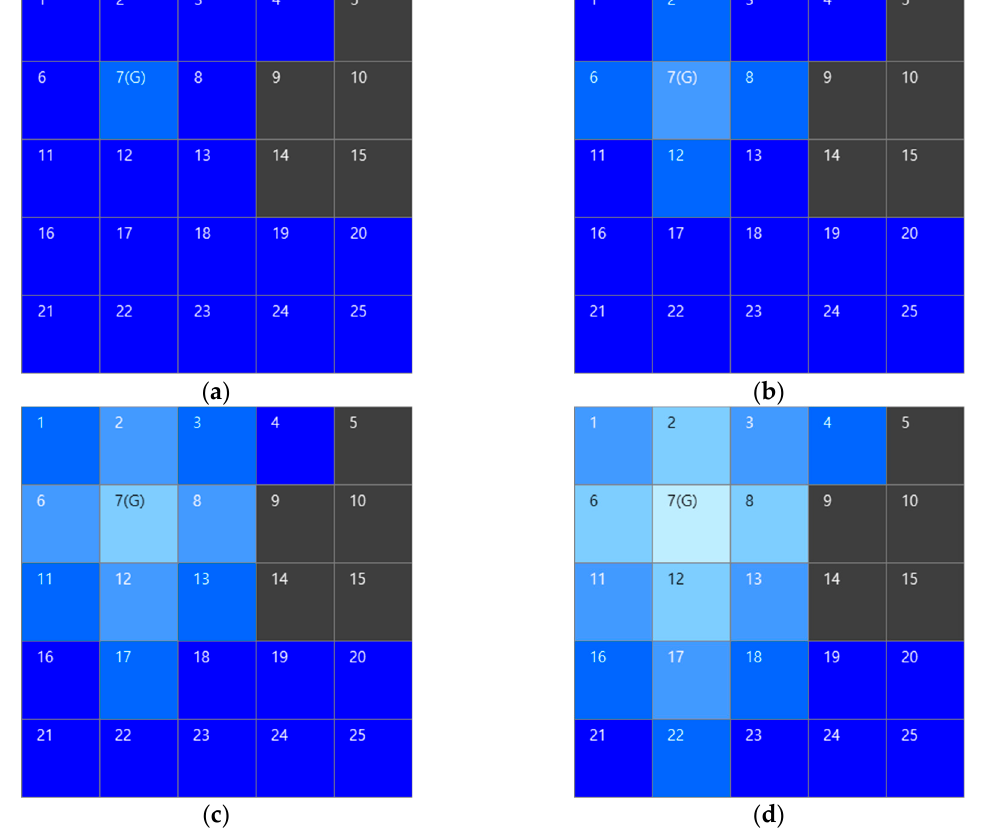
Figure 5. The sequences of water flow in water sink model. The cell number 7(G) is goal or plug hole and cell number 5, 9, 10, 14, and 15 are obstacles. These examples show the progress of water drainage as: ( a ) first turn, only plug hole cell is concerned about drainage; ( b ) second turn, plug hole, and the adjacent cells are involved in drainage; ( c ) third turn; and, ( d ) fourth turn, the cells that are involved in the drainage gradually expand and the each cell color becomes gradually brighter.